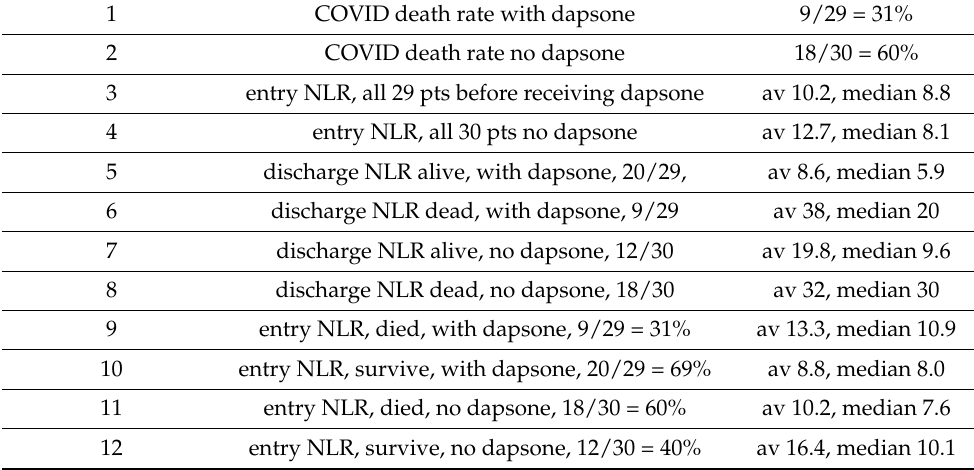
Table 1. NLR data, COVID19 patients admitted to ICU.